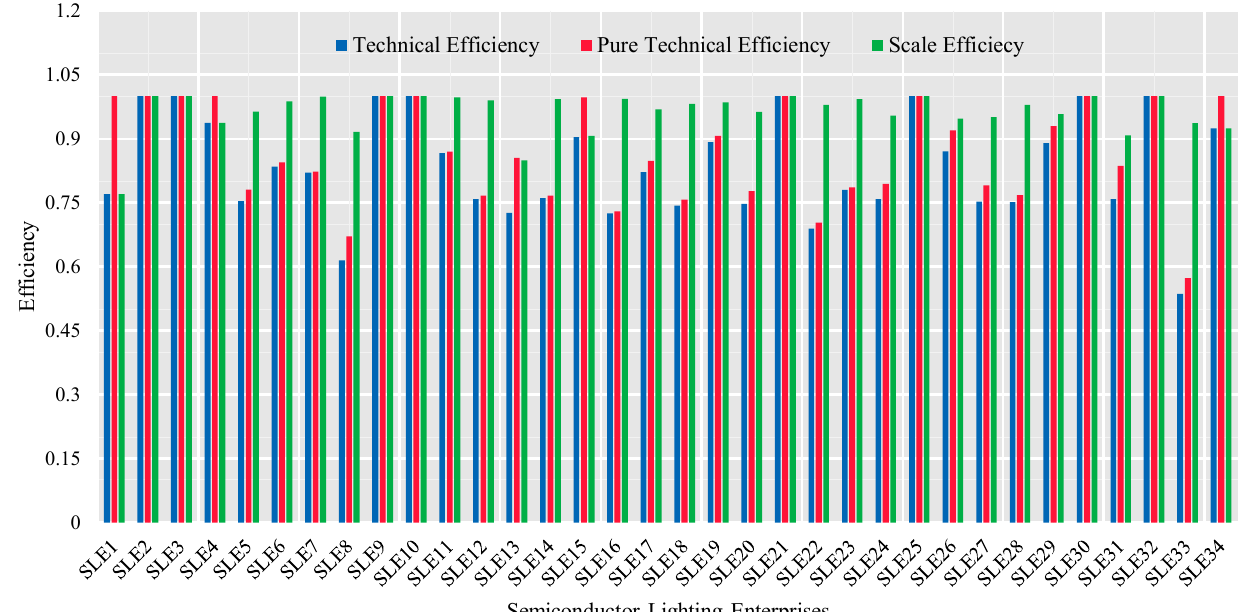
Figure 5. Comprehensive technical efficiency evaluation results of 34 Chinese LED energy enterprises in 2017.